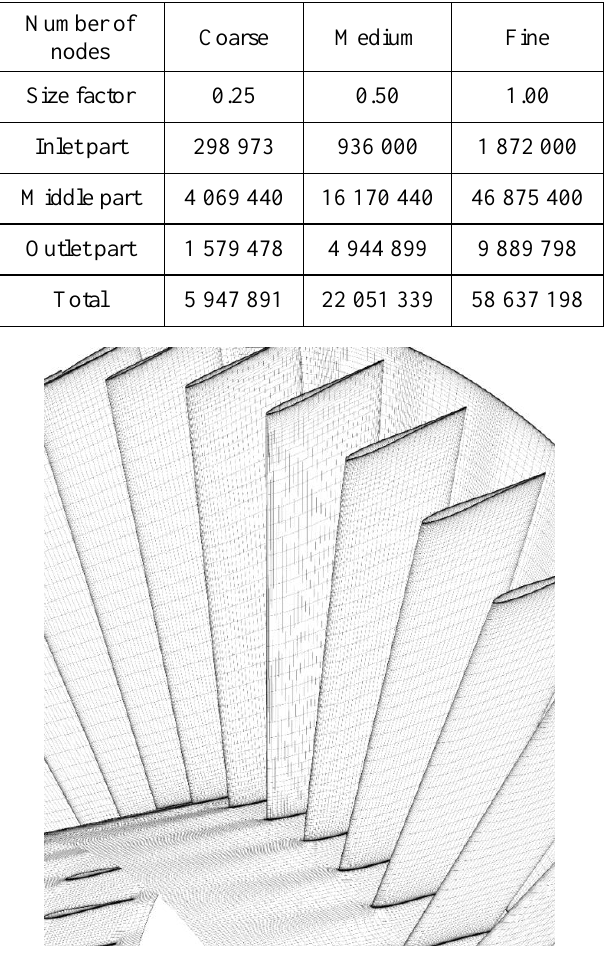
Fig. 7. Detail of the hexahedral mesh of the middle section.